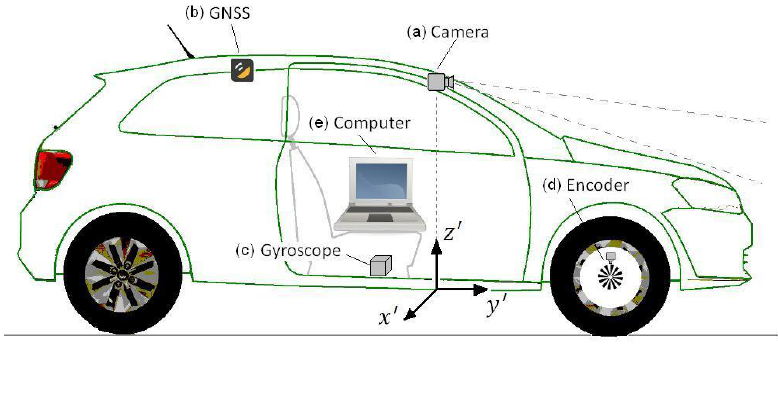
Figure 5. The prototype vehicle and the sensors